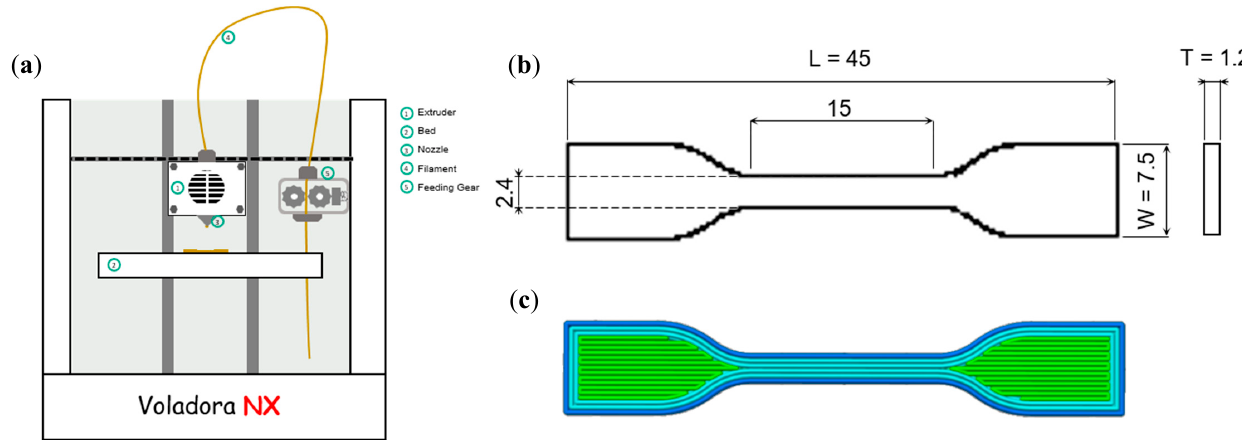
Figure 1. ( a ) Schematic model of the Tumaker Voladora NX 3D printer, ( b ) dimensions of imported dog-bone design and ( c ) computer aided design and infill